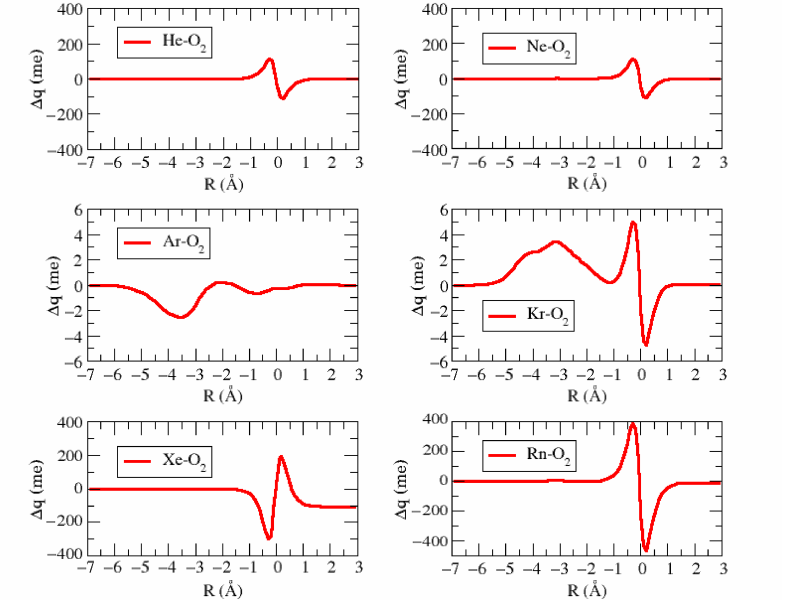
Figure 4. Charge Displacement ( ∆ q ) pictures for the most stable configuration for the Ng–O 2